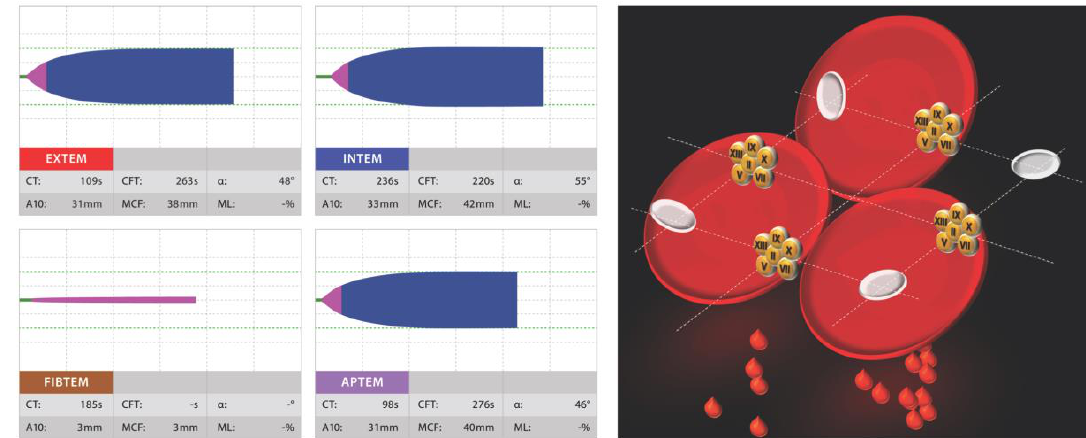
Figure 5. Low fibrinogen level: left, displayed by a four channel ROTEM ® report (EXTEM, INTEM, FIBTEM and APTEM); right, by Visual Clot visualization technology.